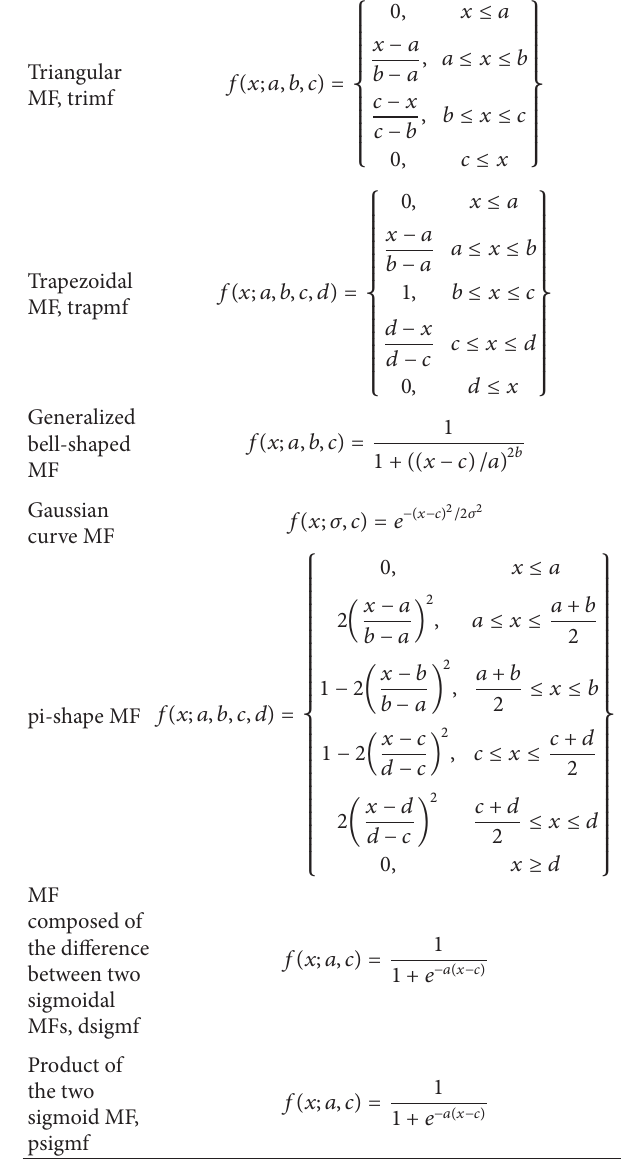
Table 1: Chemical analysis of materials.